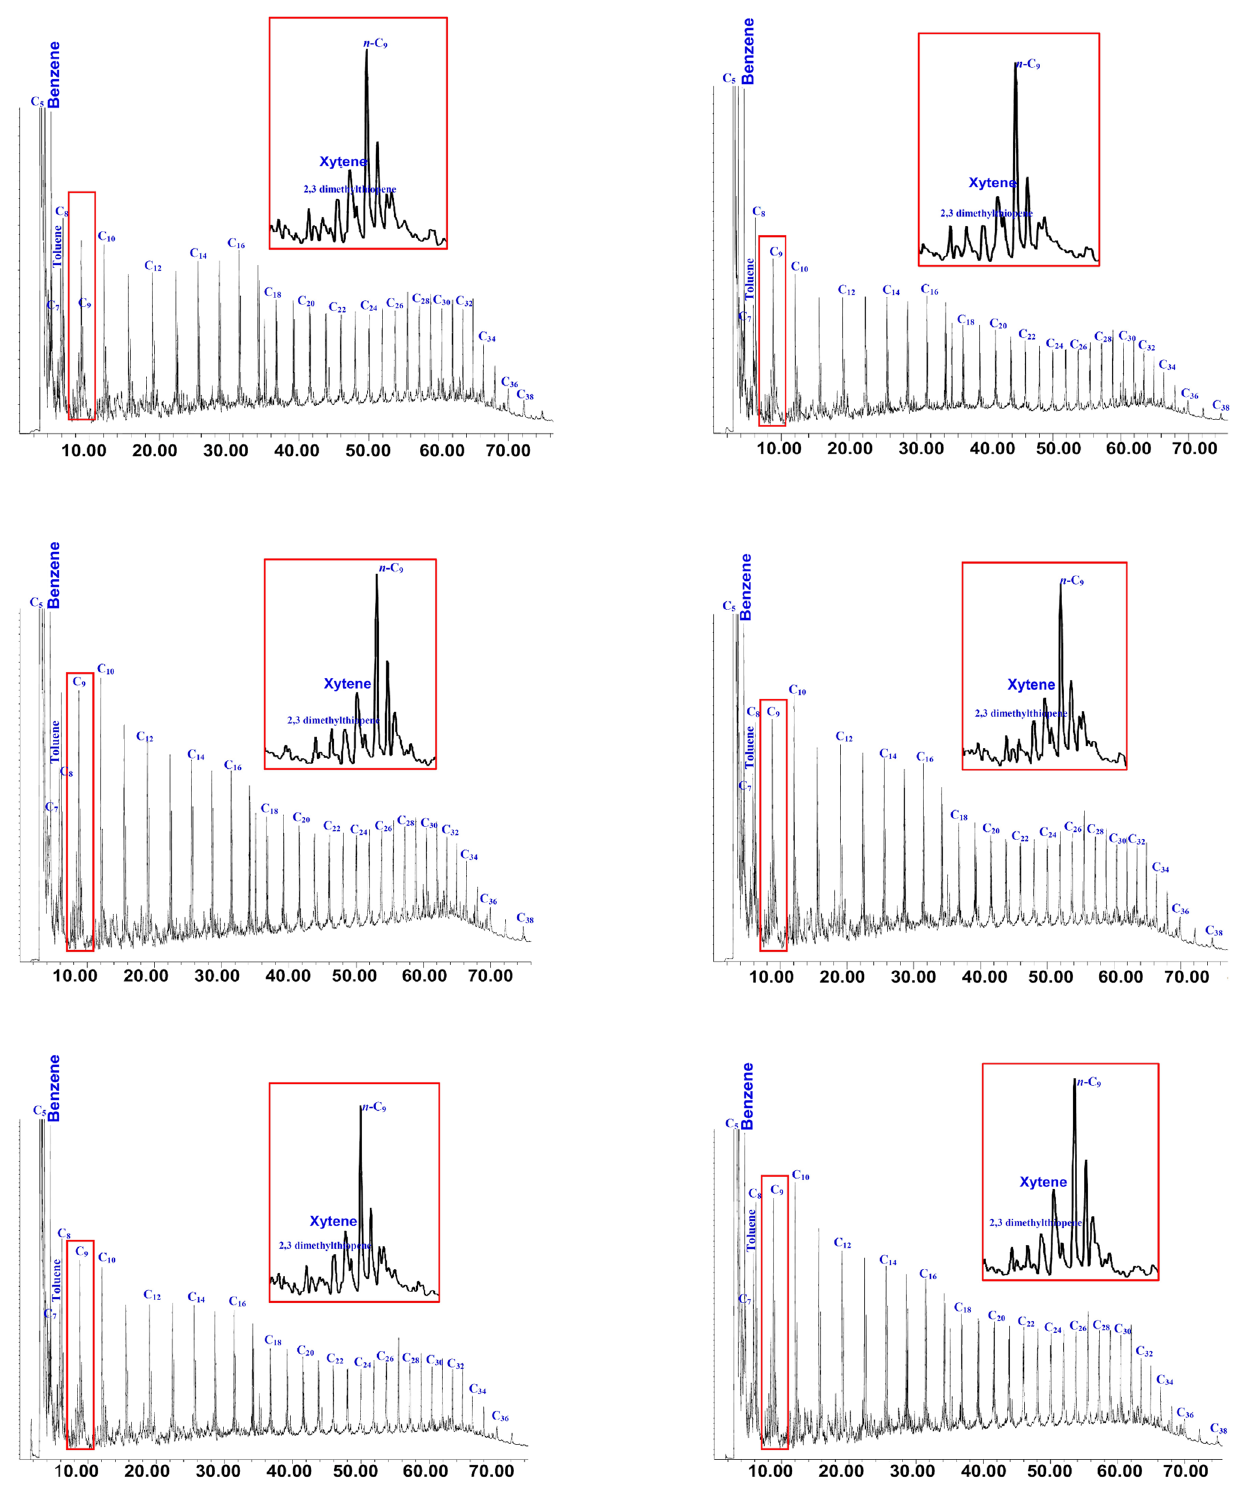
Figure 8. Pyrolysis GC pyrograms of selected analyzed Palana shale samples, showing labeled peaks of n -alkene/alkane doublets, sulfur-lean organic matter, and aromatic hydrocarbons (toluene, xylene, and benzene) used as kerogen and petroleum type proxies (see Fig.